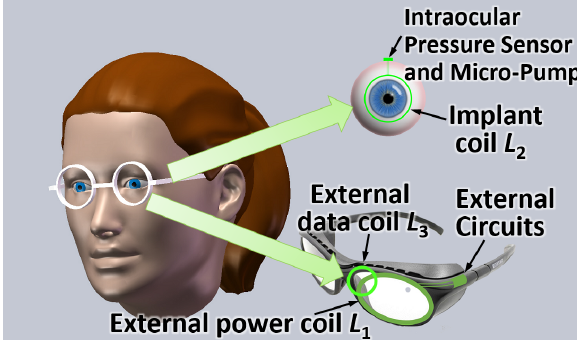
Figure 1. Application scenario of the intraocular sensor system for glaucoma